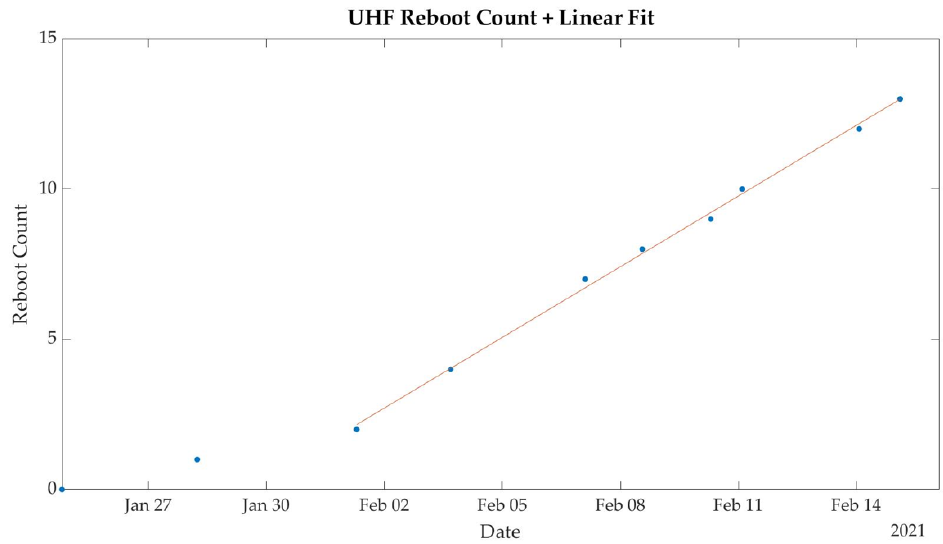
Figure 19. IDEASSat UHF transceiver reboot count as a function of time and linear regression.